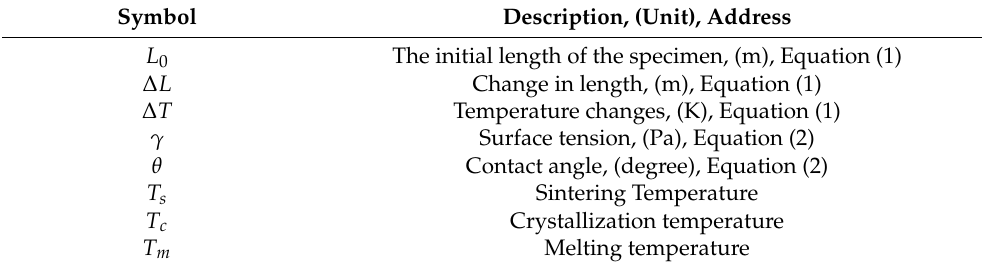
Table 1. Description of the scientific symbols.